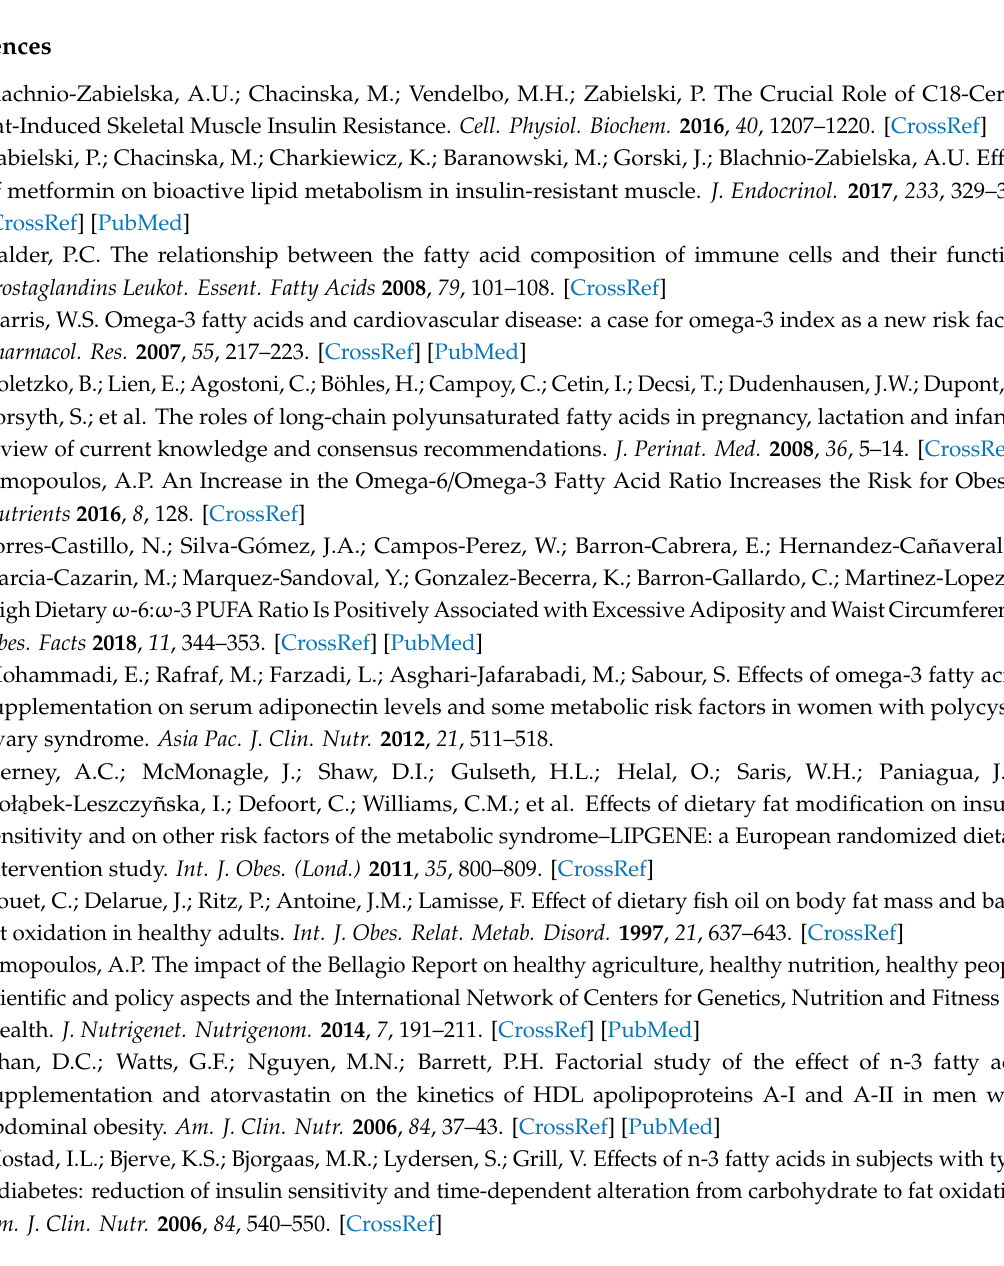
Figure S1: Visceral adipose tissue CPT1 B protein expression with reference gene GAPDH—exposure time 14.0 s; Figure S2: Subcutaneous adipose tissue CPT1 B protein with reference gene GAPDH—exposure time 30.0 s; Table S1: Total fatty acids compositions of purified diets (mg / g)—in situ transesterification; Table S2: The quality and quantity of total RNA in visceral and subcutaneous adipose